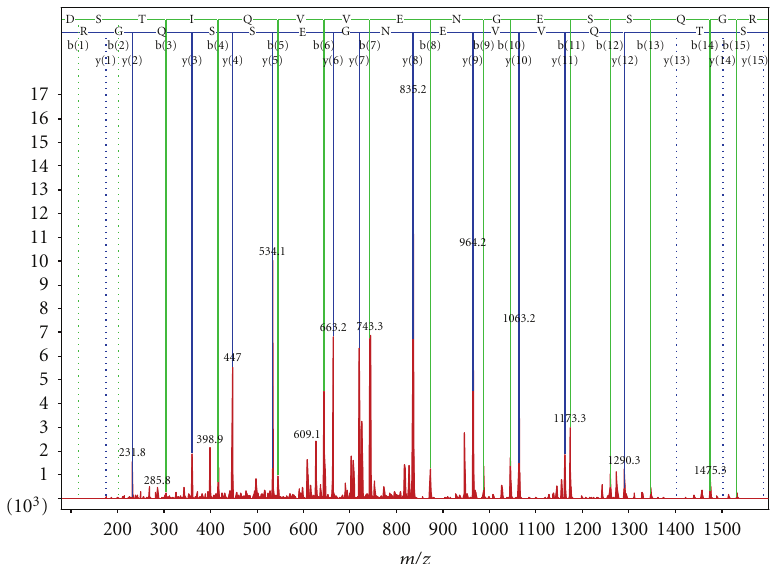
Figure 5: A representative MS/MS spectrum of peptide DSTIQVVENGESSQGR derived from uromodulin. The most intensive spot on SDS-PAGE in Figure 4 was in-gel digested and analyzed by LC-MS/MS.